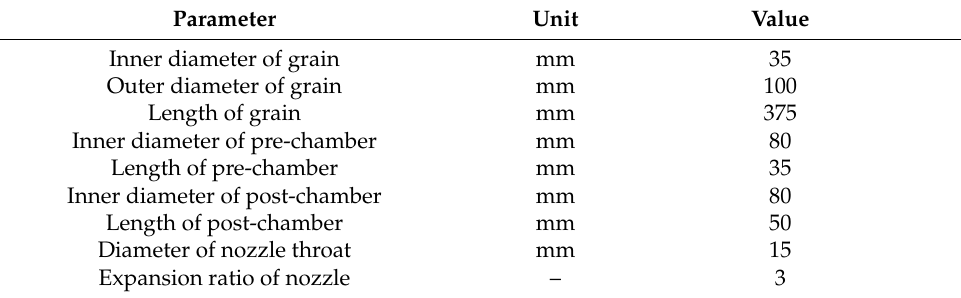
Table 2. The main design parameters of the test motor.